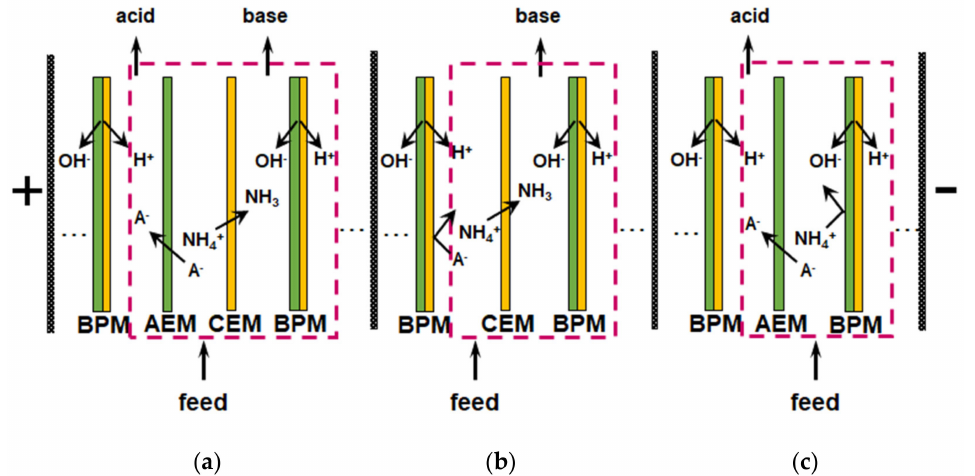
Figure 11. Schematic representation of membrane bipolar electrodialyzers with feed, acid and base ( a ), feed and base ( b ), feed and acid ( c ) repeating units and H + /OH − ions generation at the bipolar boundary of the cation and anion-exchange layers of a bipolar membrane. The salt (NH 4 A) contained in the feed solution is converted into acid and alkali as the result of this generation; A − denotes the anions. Based on